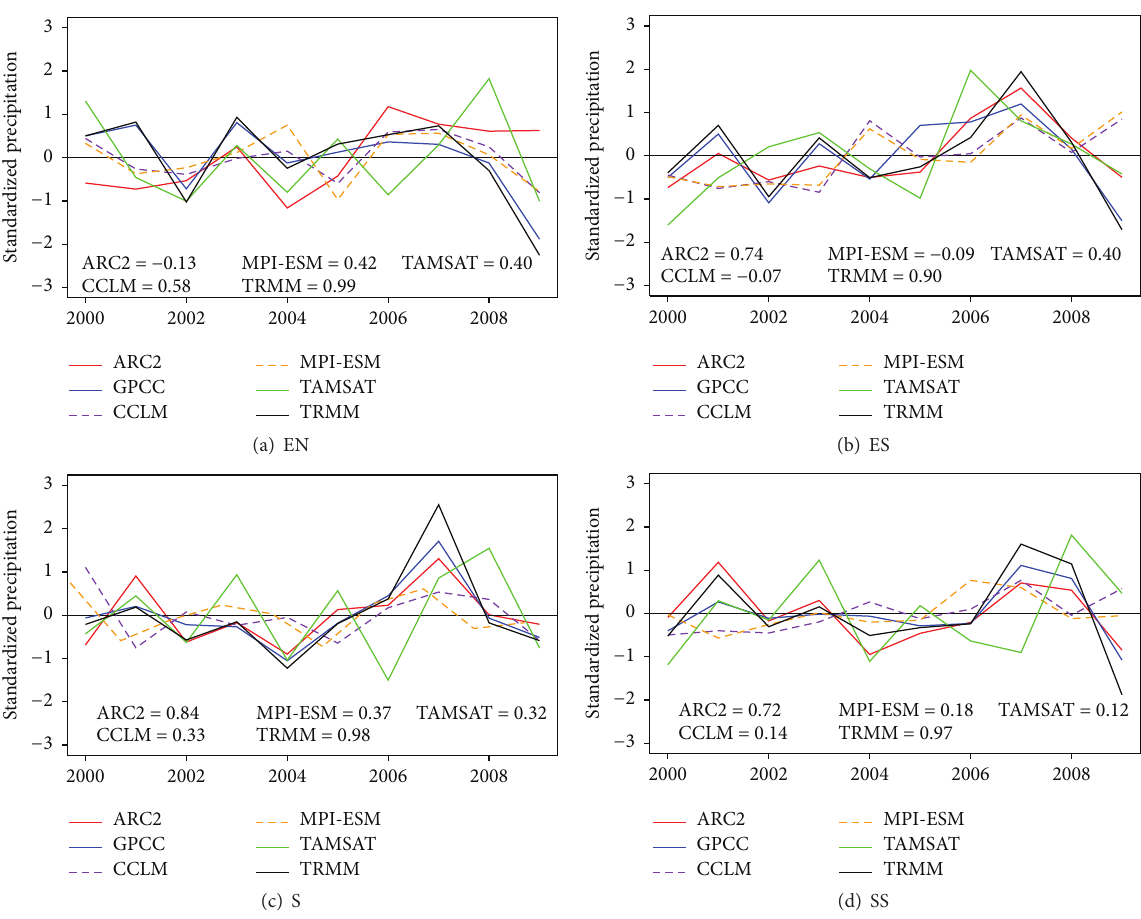
Figure 5: Interannual variability of standardized daily precipitation (mm/d) and JJAS mean. Rainfall correlations (observed and modelled with respect to GPCC) are shown inside the figure